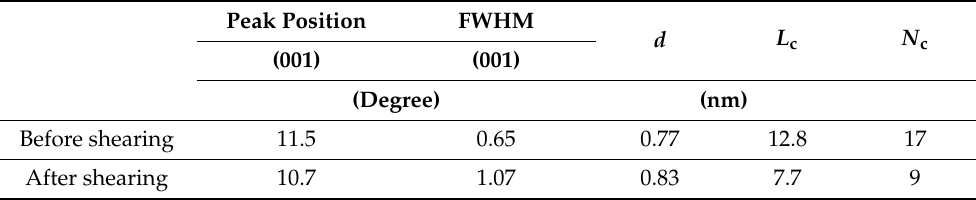
Table 2. XRD characteristics of freeze-dried graphene oxide before and after shearing *. Peak Position FWHM